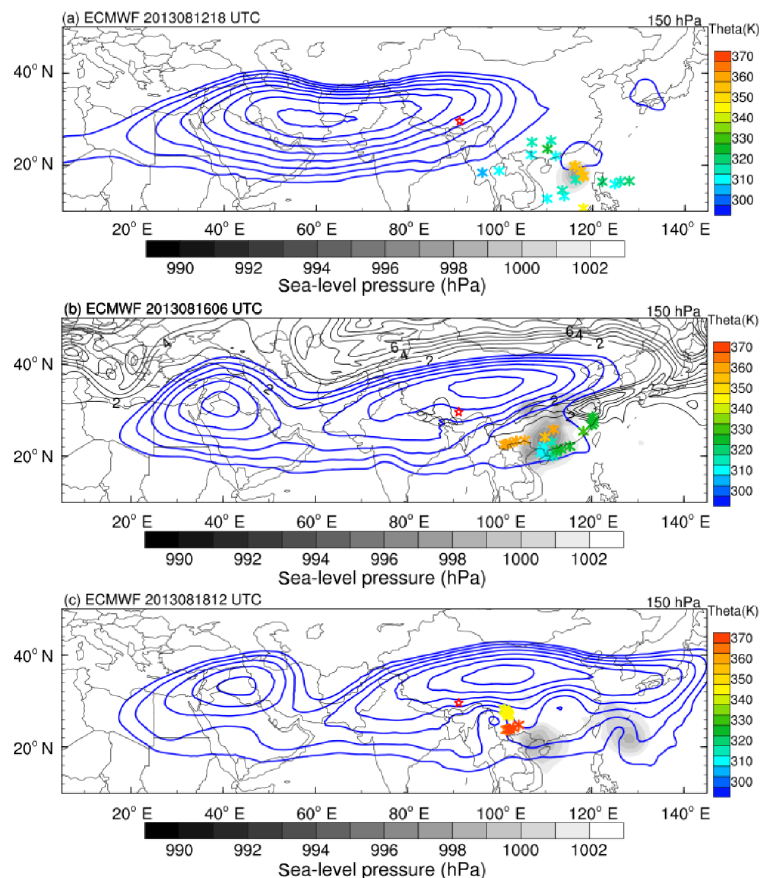
Figure 7. The same format as Fig. 6, but for typhoon Utor. In addition, PV isolines ( > 2PVU, solid black lines) are shown in Fig. 7b.